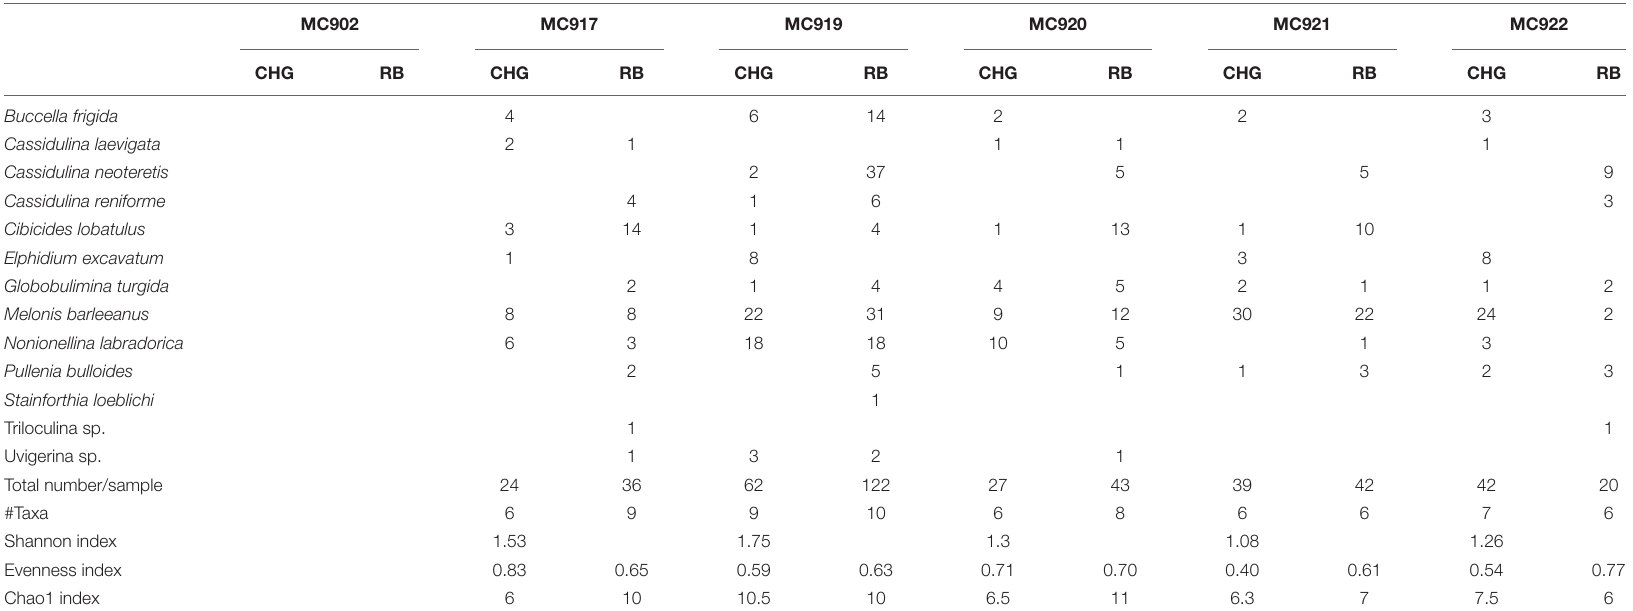
TABLE 4 | Number per sample of CellHunt Green labeled (CHG) and Rose Bengal stained (RB) foraminifera (direct count), and Shannon diversity index from active GHP1 and inactive GHP5. MC902